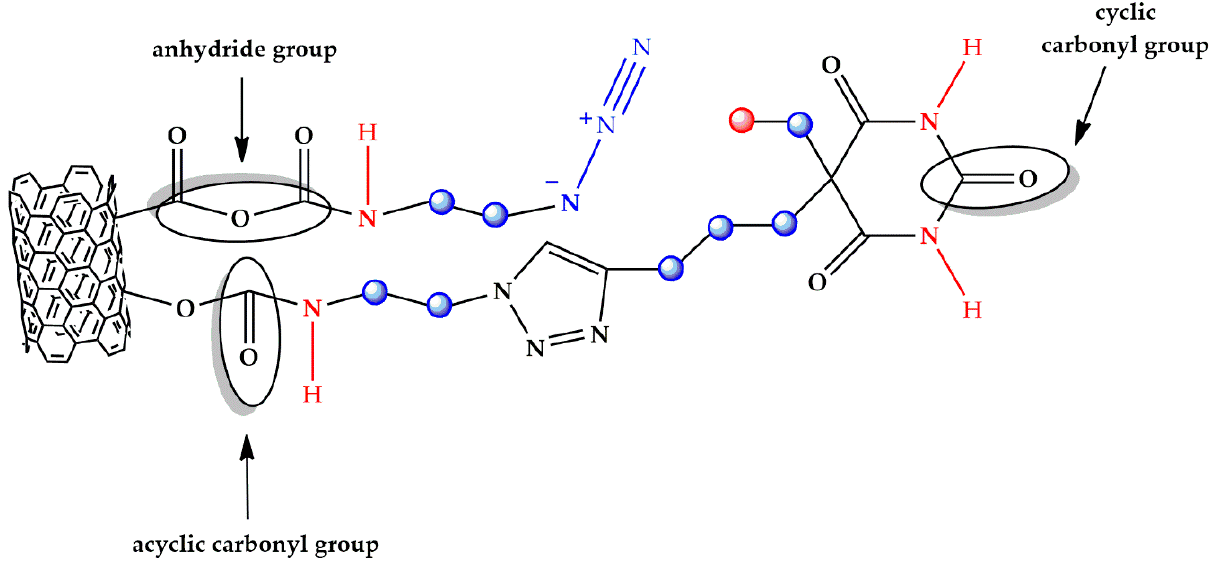
Figure 3. Chemical structure of MWCNT-b with the characteristic functional groups highlighted.